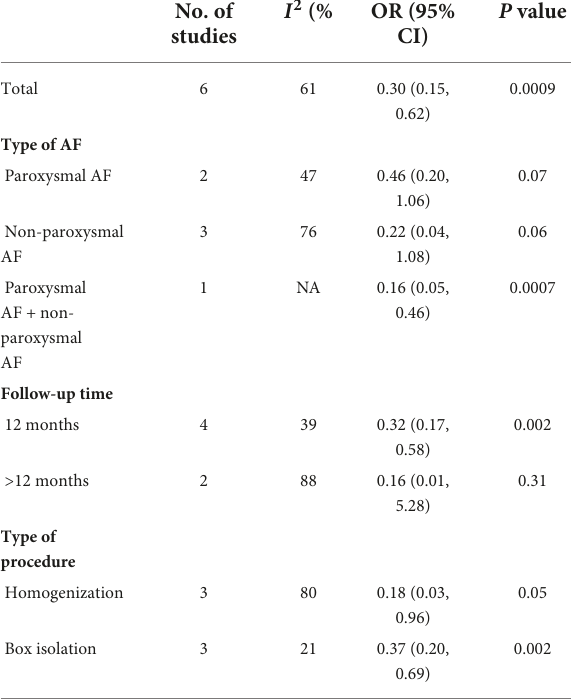
TABLE 4 Subgroup analysis according to type of AF, follow-up time, type of procedure.